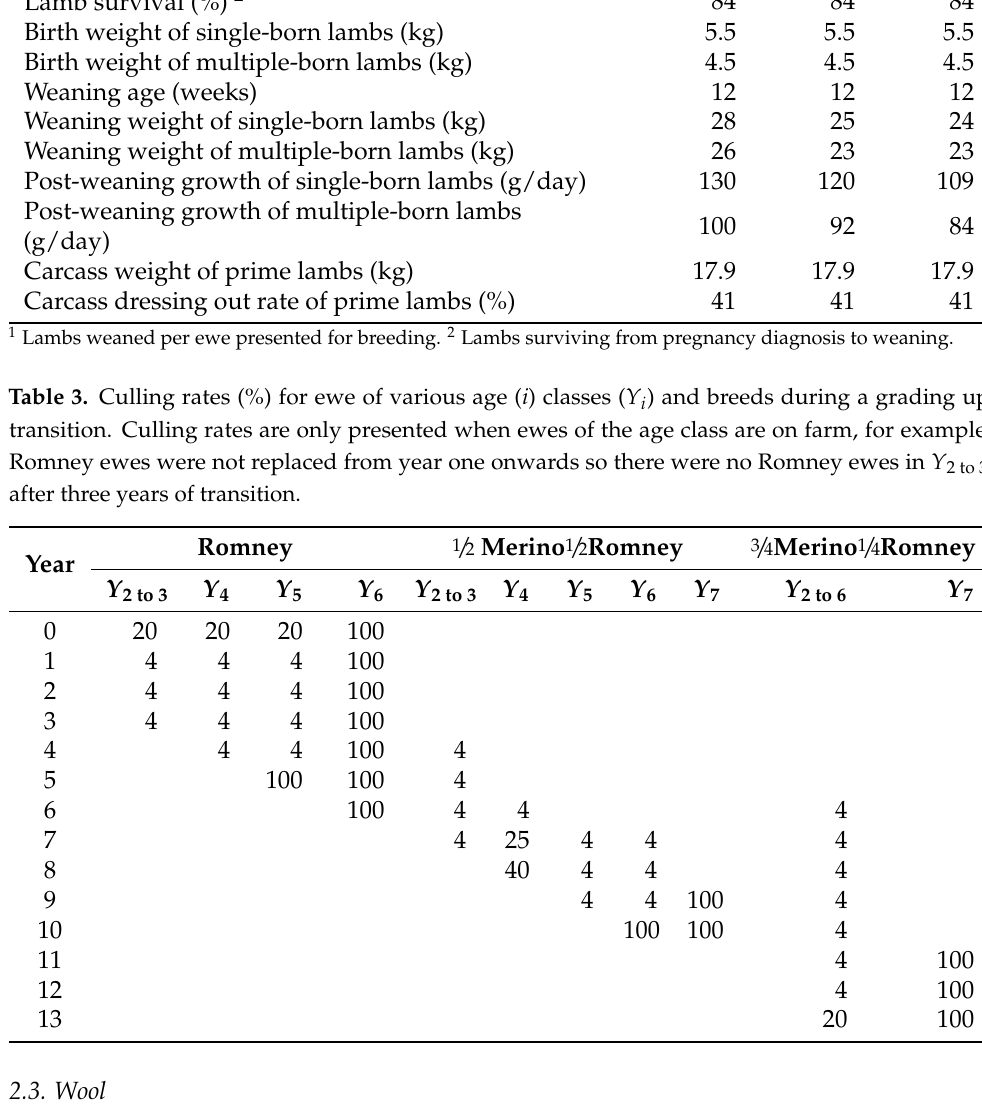
Wool produced by the purebred Romney flock was assumed to have a mean of 36 µ m, classed as coarse, and variation in fibre diameter was ignored. It was assumed all Romney lambs on-farm in January were shorn. For each flock, total wool production was estimated from mean mature greasy fleece weight (Table 2) in combination with sheep numbers and adjustment parameters from Table